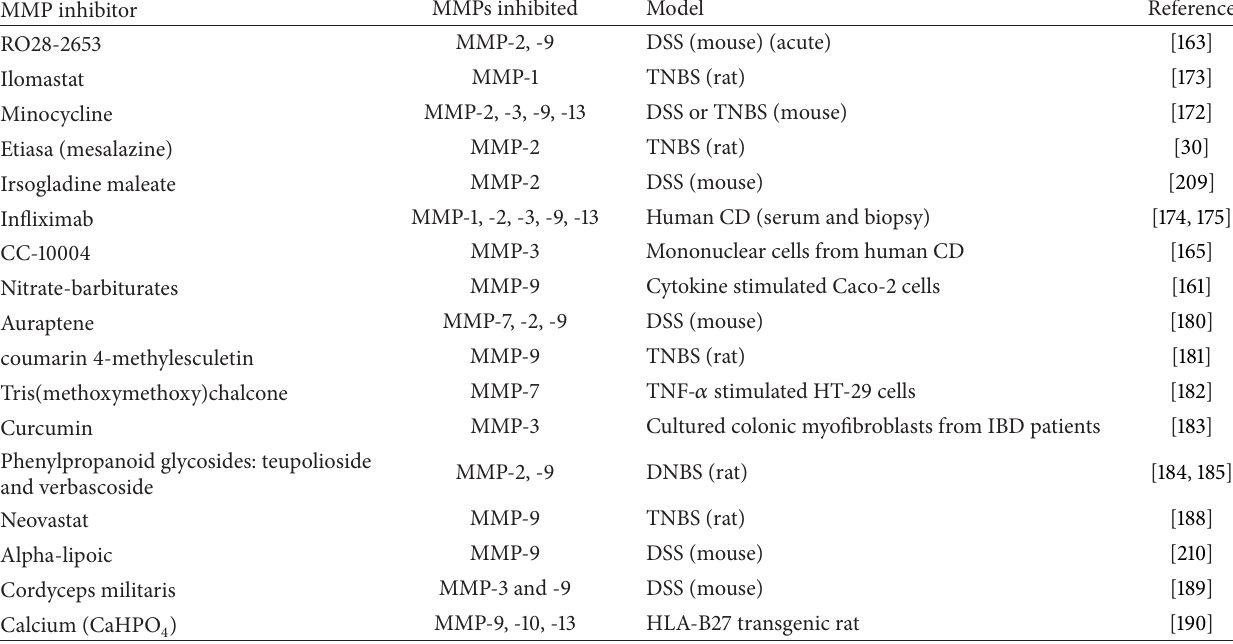
Table 2: Recently reported MMP inhibitors in models of intestinal inflammation. Novel MMP inhibitors, plant extracts tested in IBD models, and existing IBD therapies are included where MMP-9 expression or activity has been